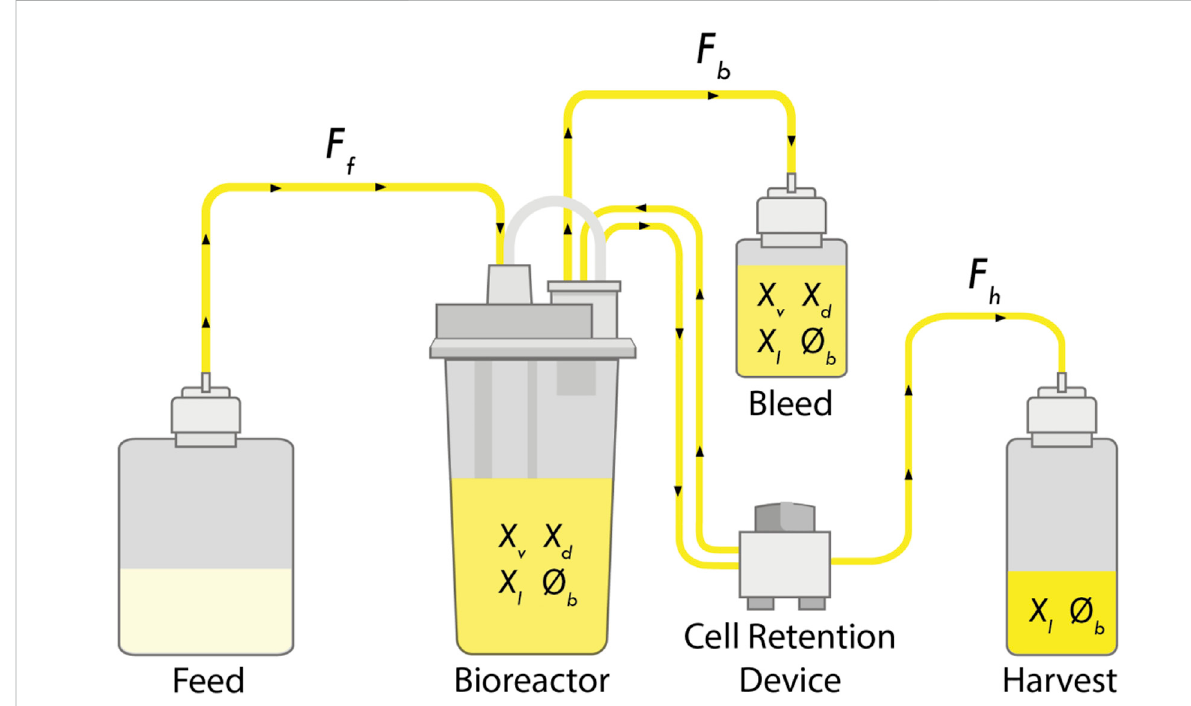
FIGURE 1 Schematic of a perfusion bioreactor. Mediais continuously fed into the bioreactor ( F f )and a cell-free harvest is continuously removed ( F h ). The cell retention fi lter is assumed to be ideal, where only the lysed cells ( X l ) and other cellular by-products ( ∅ b ) pass through while viable ( X v ) and dead cells ( X d ) are fed back into the bioreactor. The bleed stream ( F b ), containing same content as the bioreactor, is used to keep the concentration of living cells within the bioreactor constant, by removing cells in